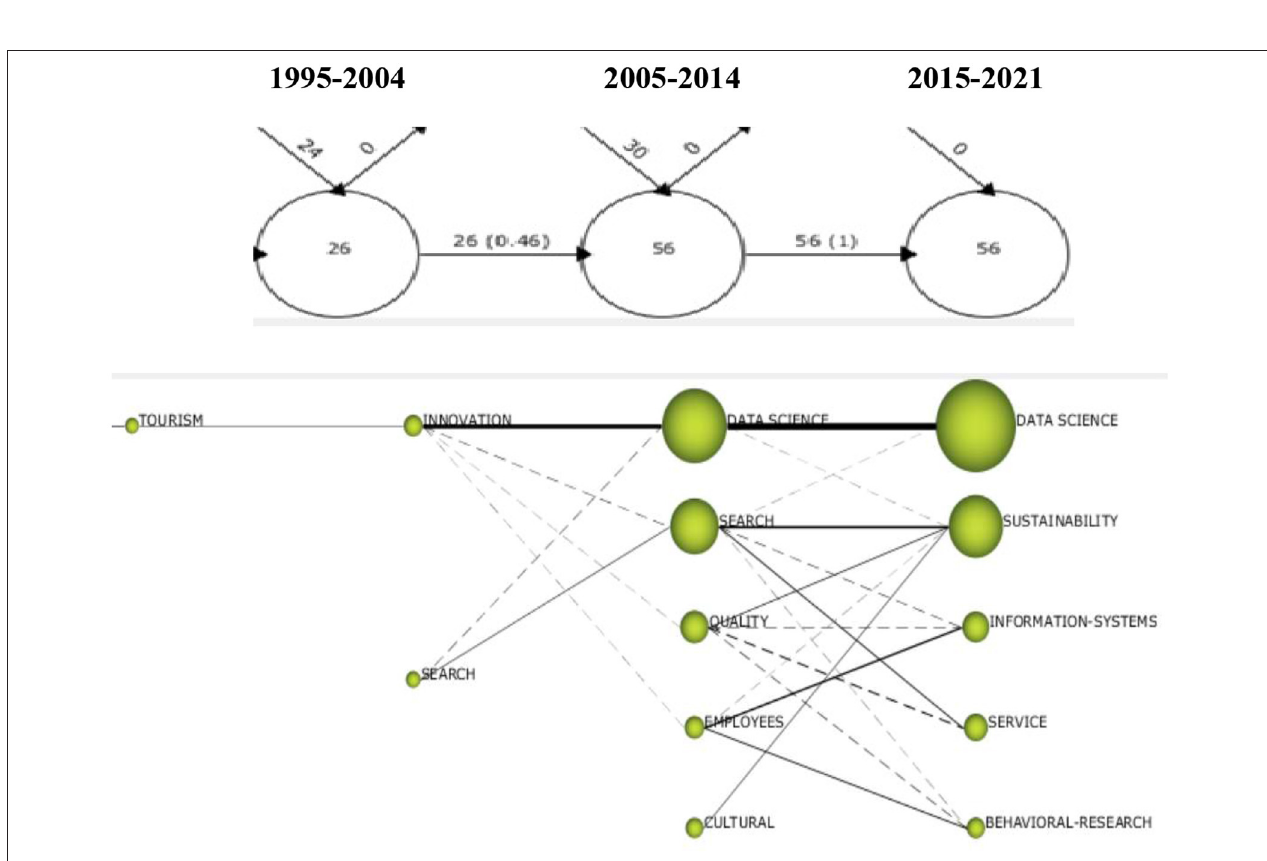
FIGURE 7 | Analysis of thematic evolution (1995–2021). Source: prepared by the authors based on SciMAT.